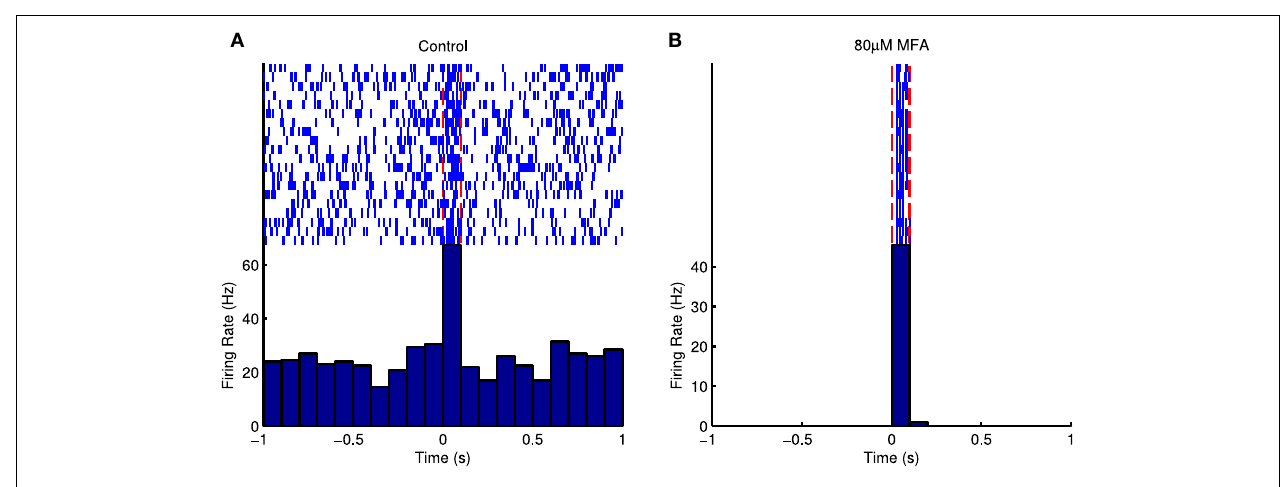
FIGURE 5 | (A) Raster plot and PSTH of an example cell in response to 100ms full-field µ LED flashes in control conditions. The light is on between the red dotted lines. It is difficult to distinguish the evoked responses from the spontaneous bursts that occur